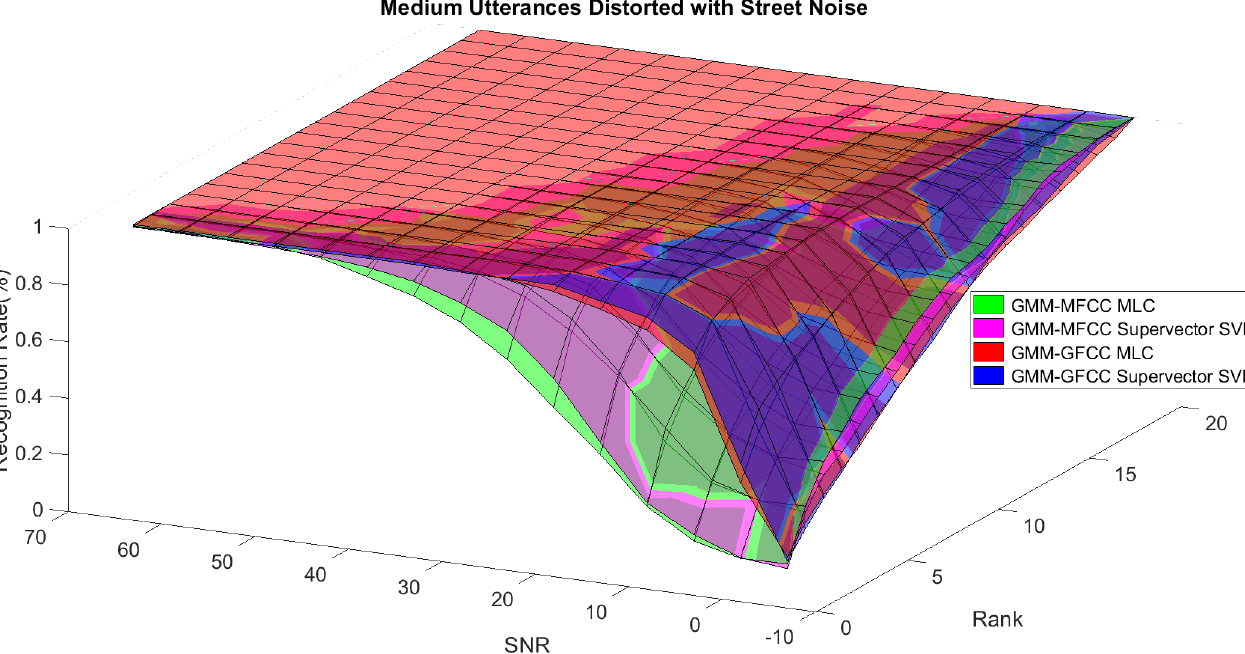
Figure 17. The 3D surface of the recognition rates for the base classifiers on medium utterances distorted with street noise.